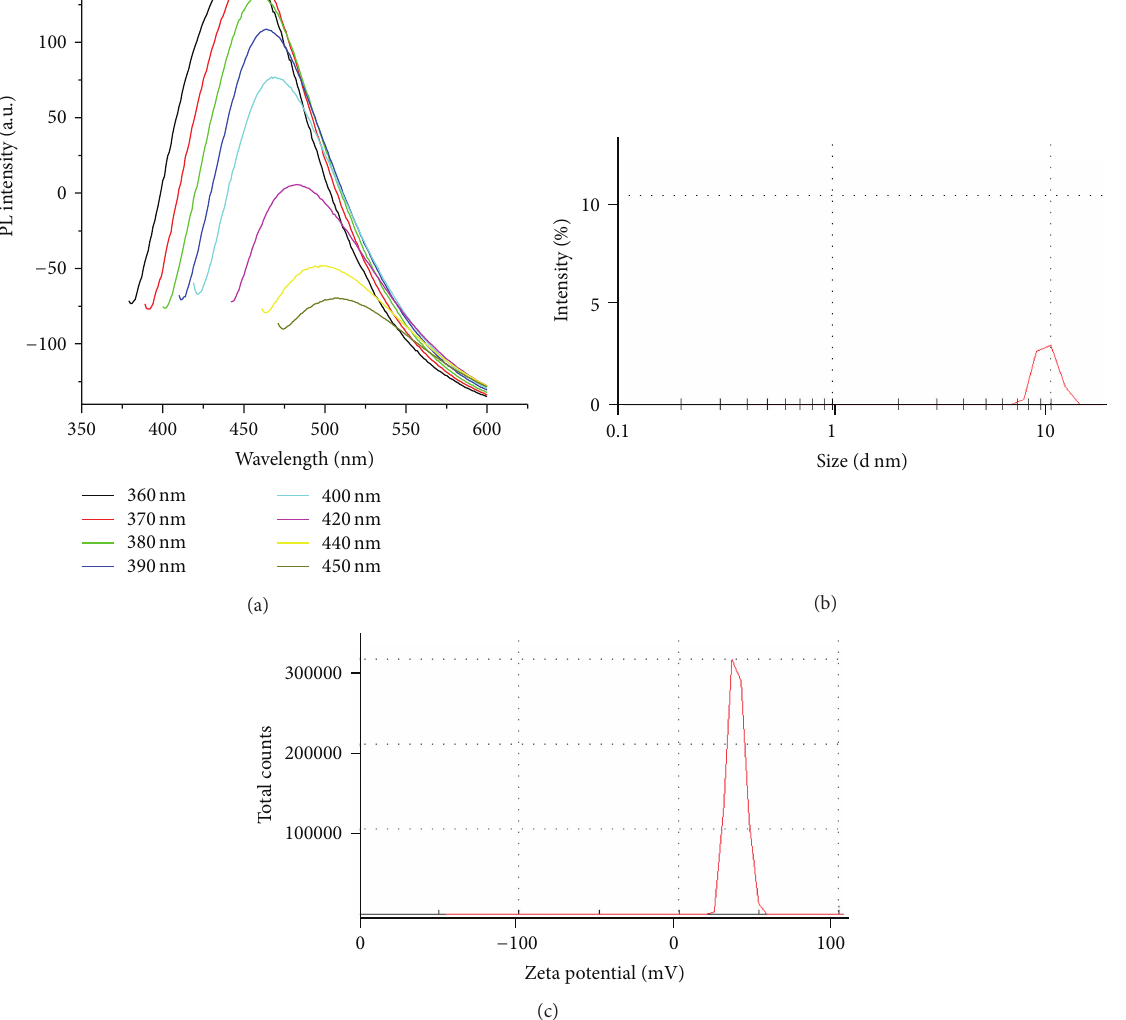
450 nm resulted in emission at 453, 455, 459, 464, 469,